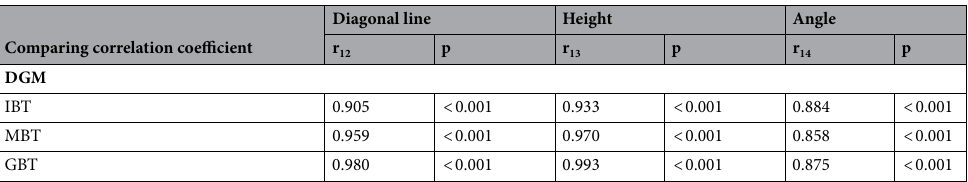
Table 3. Correlation coefficient between DGM and three techniques for diagonal length, height, and angle. r 12 , correlation coefficient for DGM and IBT; r 13 , correlation coefficient for DGM and MBT; r 14 , correlation coefficient for DGM and GBT.